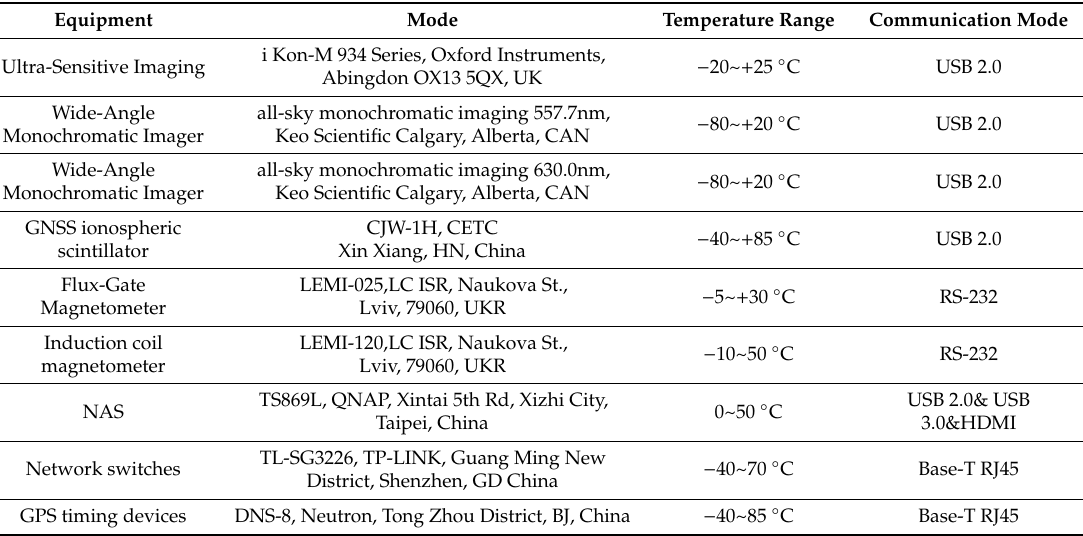
Table 1. Sensor information of the automatic weather station.